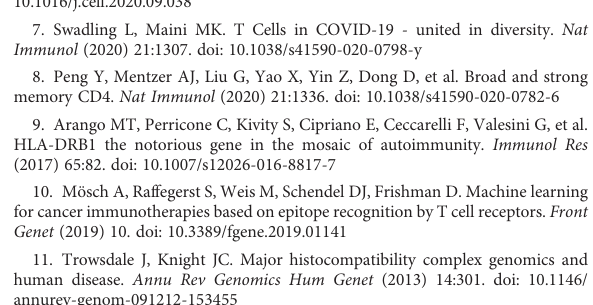
Additional comparisons of SARS-CoV epitopes and other immunogenic epitopes from the CrossTope Database. Shared fi ngerprints in the above- exempli fi ed pairs of structures, indicating that cross-reactivity non- related triggers can be a widespread phenomenon.